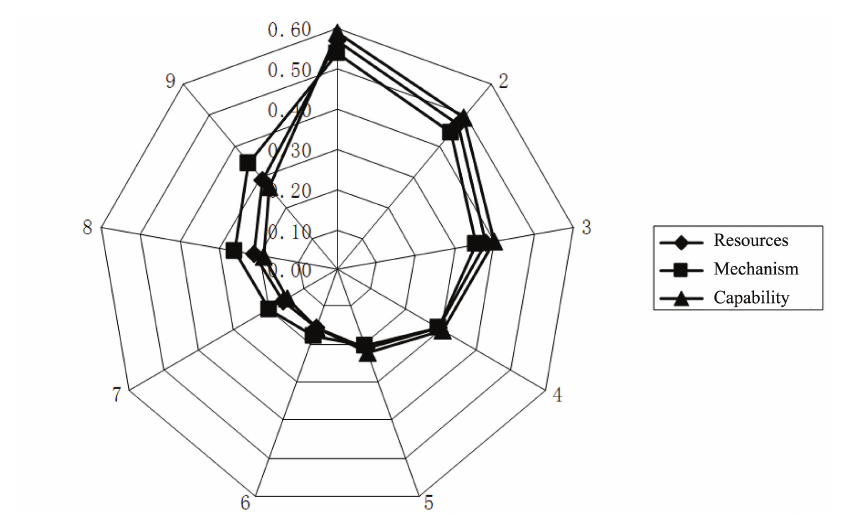
figure 4. The competitiveness level of the six main